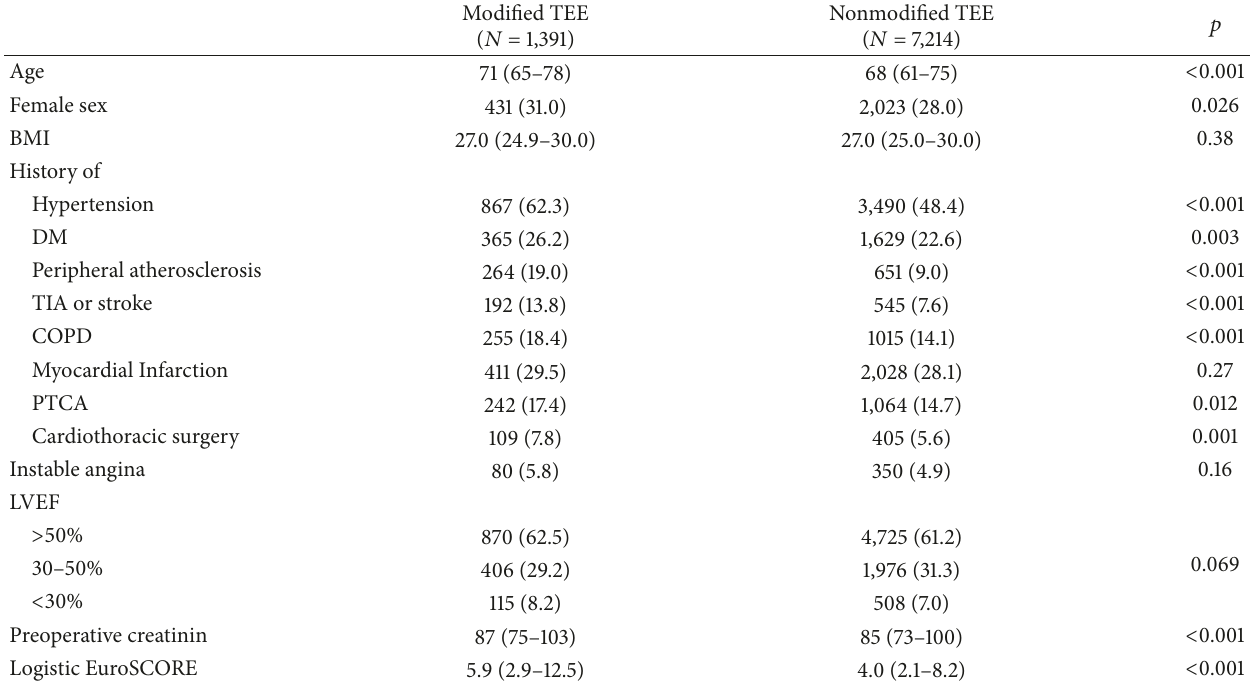
Table 2: Baseline characteristics comparing patients with and without perioperative screening with modified TEE. BMI = body mass index, DM=diabetesmellitus,COPD=chronicobstructivepulmonarydisease,TIA=transientischemicattack,PTCA=percutaneoustransluminal coronary angioplasty, and LVEF = left ventricular ejection